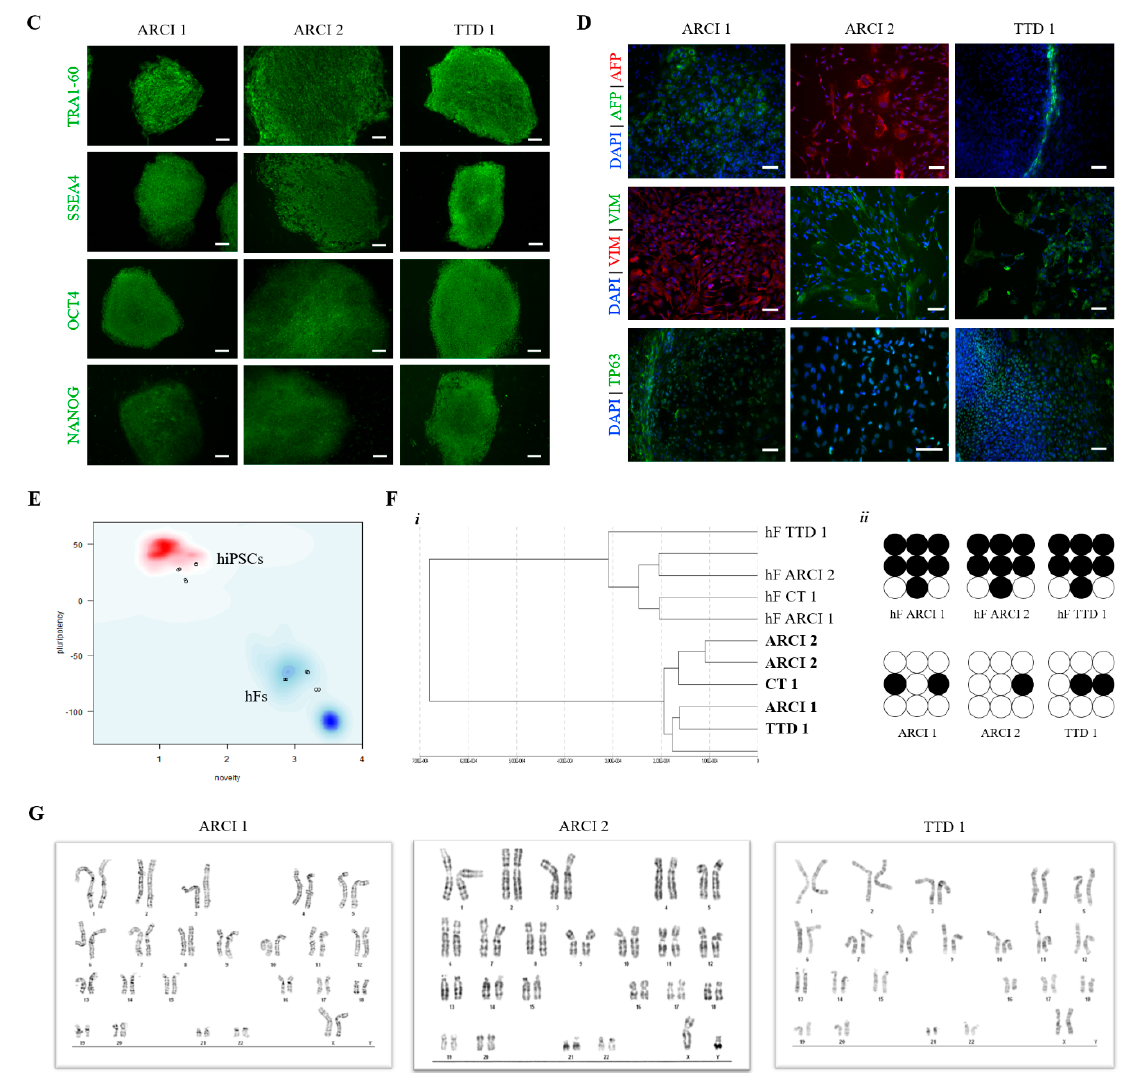
Figure 1. Validation of human induced pluripotent stem cells (hiPSCs) generated from ichthyosis patients. ( A ) Embryonic stem cell (ESC)-like morphology (upper panel) and alkaline phosphatase positive activity (lower panel). Scale bar 250 μ m. ( B ) Relative expression of pluripotency transcription factors OCT4 , NANOG and SOX2 in hiPSCs compared to untransfected human fibroblasts (hFs) by RT-qPCR ( n = 3). ( C ) Expression of pluripotency markers TRA1-60, SSEA4, OCT4 and NANOG by immunocytochemistry. Expression of these markers was not visible in CF1 mouse embryonic fibroblasts (MEFs). Scale bar 250 μ m. ( D ) In vitro differentiation ability of hiPSCs into cells of the 3 germ layers. hiPSCs were spontaneously differentiated and stained positive for specific markers for the 3 germ layers: alpha-fetoprotein (AFP) (endoderm), vimentin (VIM) (mesoderm) and p63 (ectoderm). Scale bar 75 µ m. ( E ) Pluritest ® analysis of hiPSC whole gene expression showed hiPSCs cluster within the pluripotency “cloud” (red) while respective hFs were allocated close to the blue “cloud” that corresponds to differentiated cells. ( F ) Global DNA methylation status of hiPSCs: ( i ) cluster analysis grouped both cell types in two distinct groups; ( ii ) CpG islands (represented as circles) in OCT4 promoter region showing demethylated CpGs (white circles) in hiPSCs compared to highly methylated status in hF CpGs (black circles). ( G ) Karyograms of hiPSC lines detected by G-banding